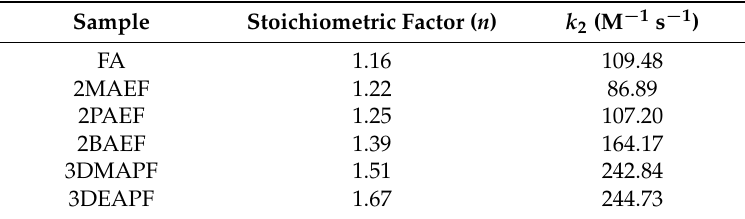
Table 4. Rate constant, k 2 (M − 1 s − 1 ) and stoichiometric factor ( n ) for reaction medium of DPPH • (60 µ M) and 100 µ M of FA or synthesized